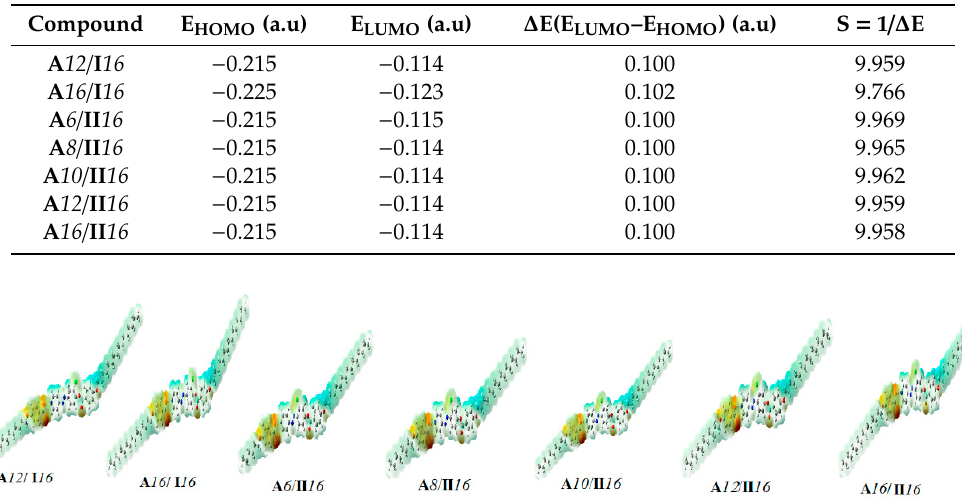
Table 4. Molecular orbital energies and global softness ( S ) of A 12 / I 16 , A 16 / I 16 and A n / II m.